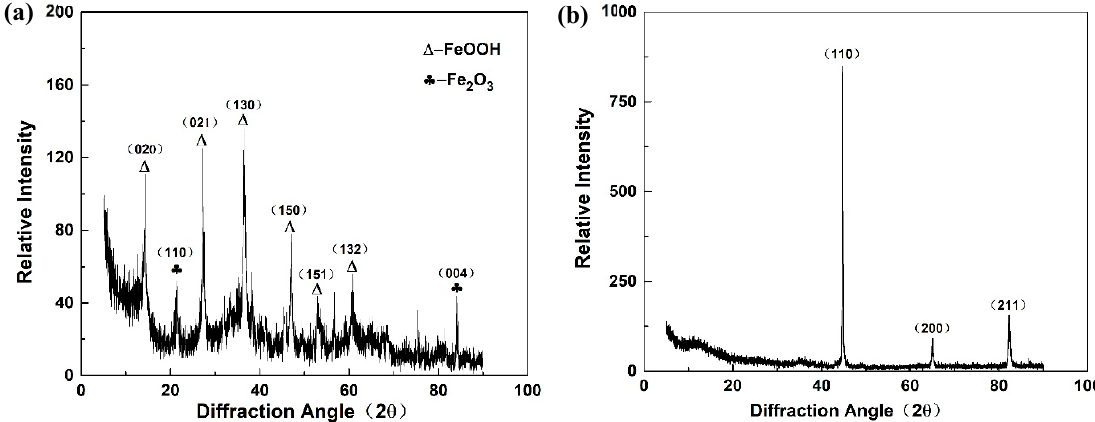
Figure 15. X-ray diffraction (XRD) analysis of the 35CrMoV steel: ( a ) corrosion products; and ( b ) matrix.